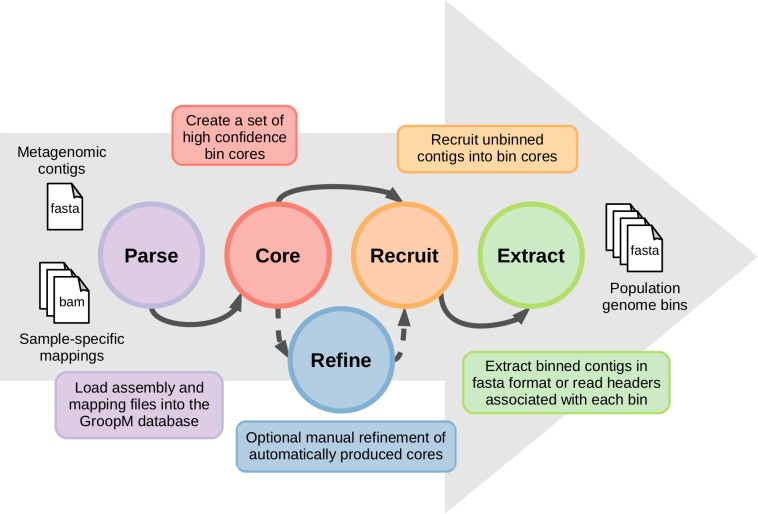
An overview of the GroopM workflow.GroopM has five stages, beginning with file parsing and ending with bin extraction. The refine step is optional and can be carried out at any stage after “core” has completed.